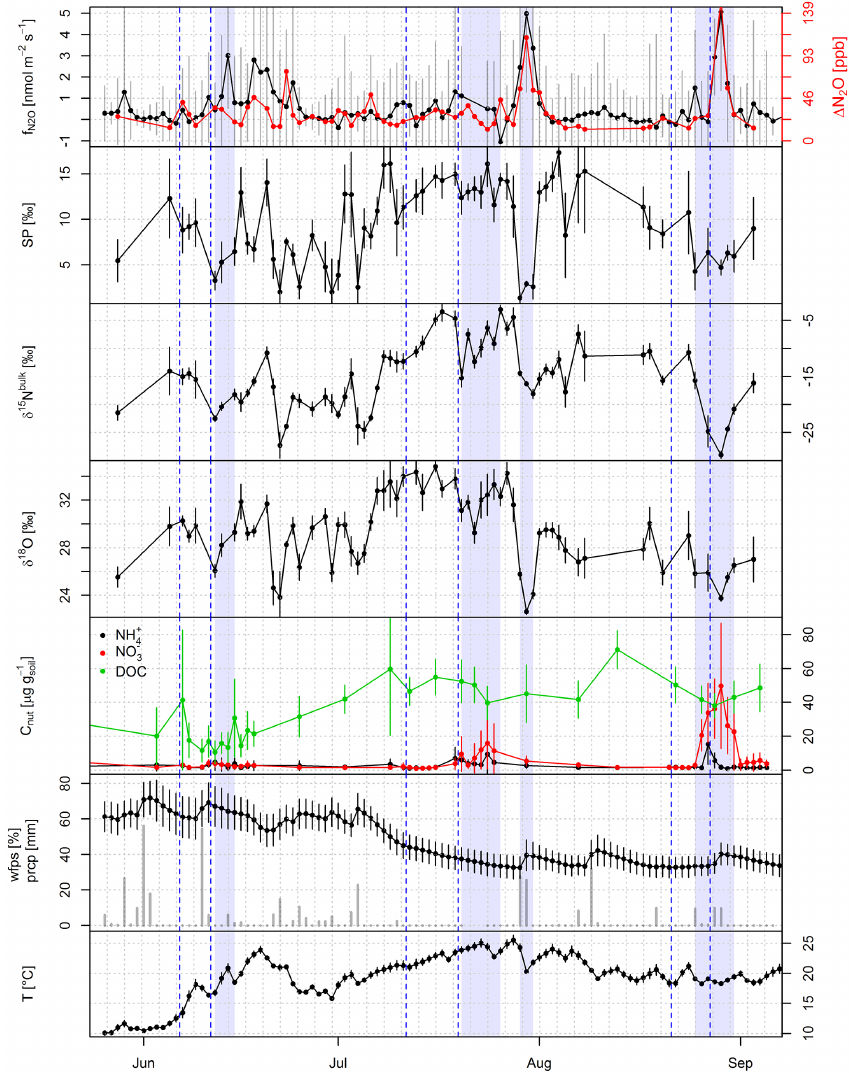
Figure 3. Noon-to-noon averaged N 2 O flux ( f N ), overnight increase in N 2 O mole fractions (difference in minimum and maximum 2 O N 2 O concentration in a noon-to-noon period; (cid:49) N 2 O), Keeling-plot-derived isotopic composition of soil-emitted N 2 O (SP, δ 15 N bulk , δ 18 O), nutrient concentrations (ammonium, nitrate and dissolved organic carbon; DOC), water-filled pore space (wfps), precipitation (prcp) and soil temperature ( T ) over the measurement period. Each pair of vertical dashed blue lines indicates the management events mowing (first line) and fertilization (second line). Transparent blue sections represent periods of N 2 O emission influenced by management or rewetting (third